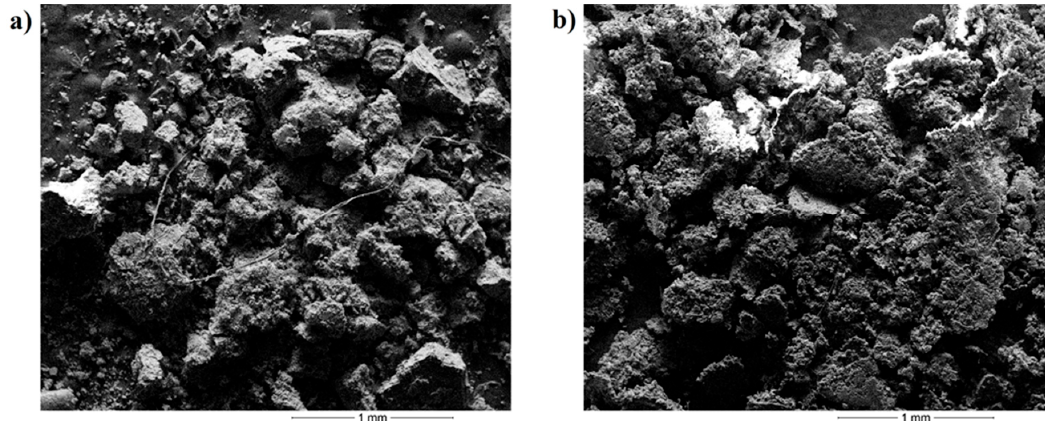
Figure 5. SEM photograph: ( a ) dust 1 (magnification 43×), ( b ) dust 2 (magnification 42×).